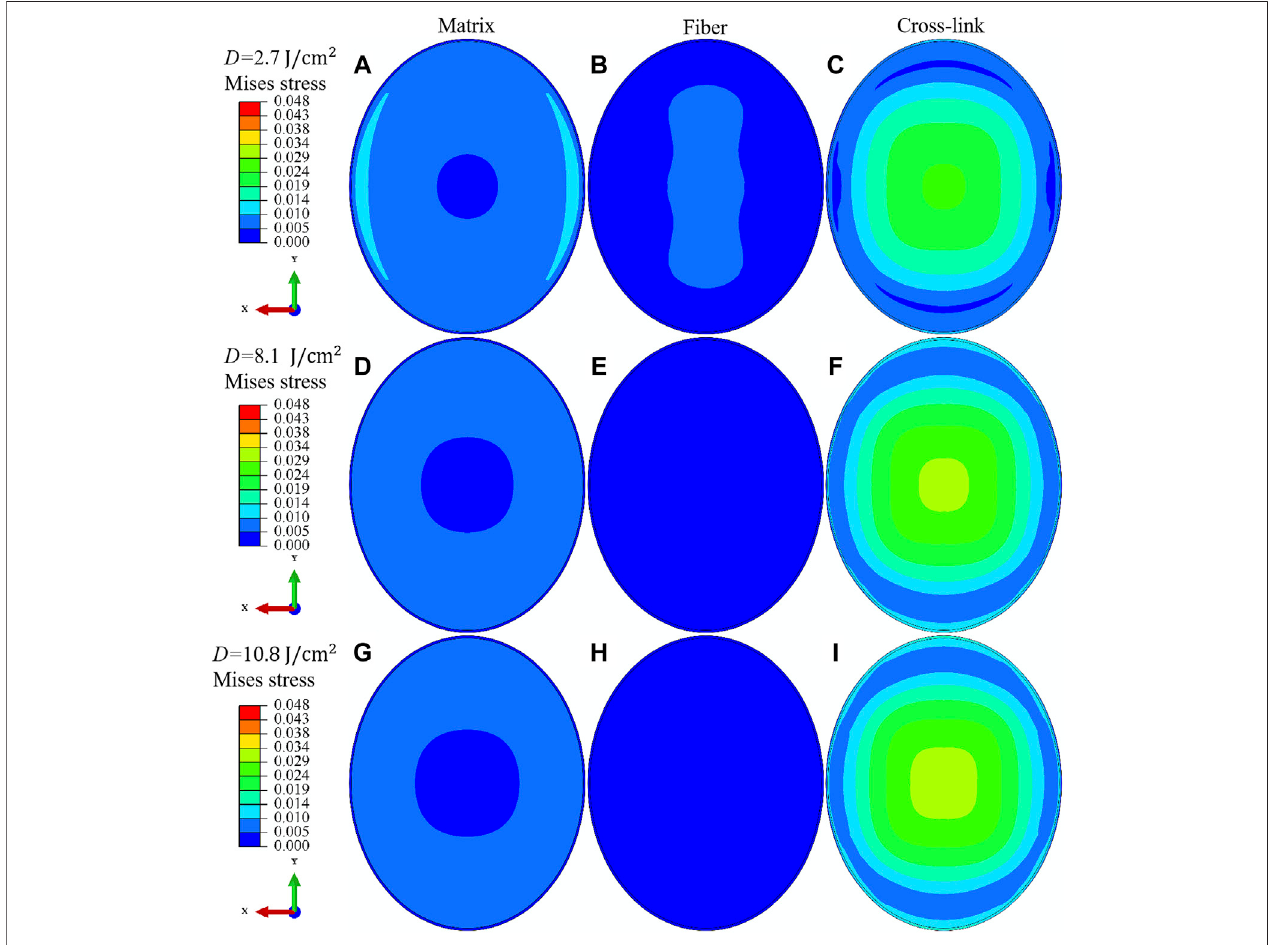
FIGURE9| Comparison oftheMises stress(unitinMPa)distribution onthemiddlesurfaceofporcine corneabetweenthematrix (A,D,G) , fi ber (B,E,H) and cross- link (C,F,I) component. The IOP equals 30 mmHg, and the irradiation dose increases from 2 . 7J/cm 2 to 10 . 8J/cm 2 .